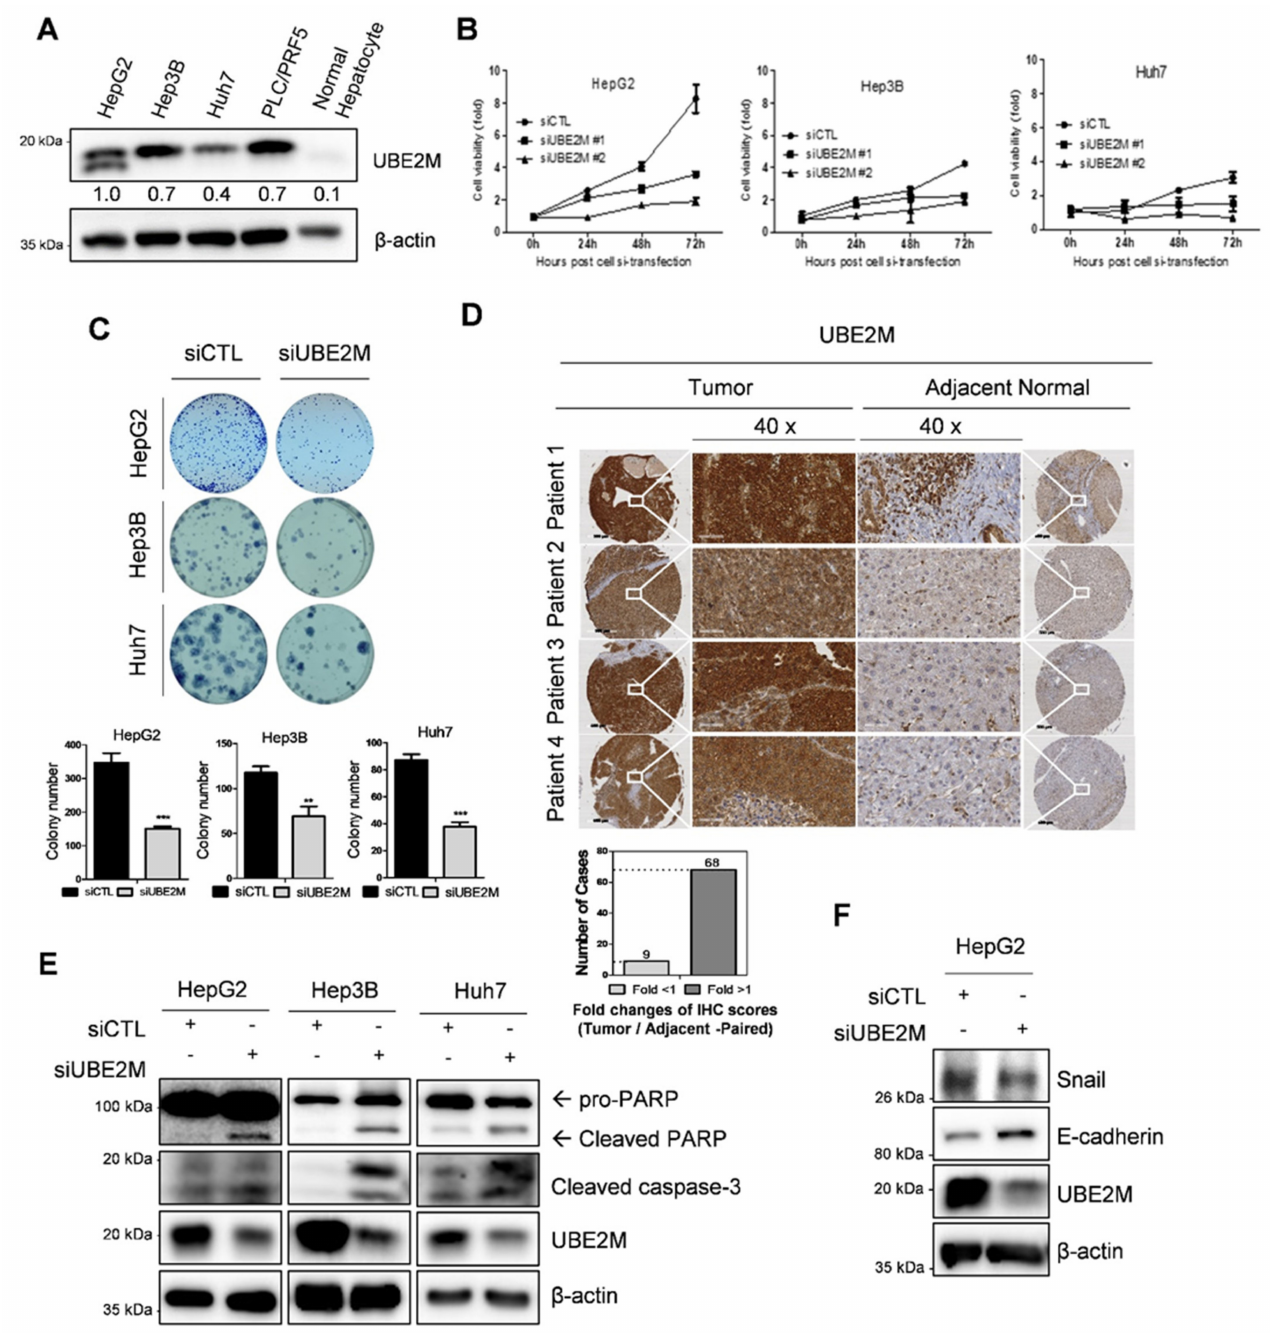
Figure 1. UBE2M overexpression in HCC cell lines and patient tissues, and cytotoxic and anti-proliferative effect of UBE2M depletion. ( A ) Endogenous expression level of UBE2M in hepatocellular carcinoma cell lines by Western blotting. ( B ) Effect of UBE2M depletion on the viability of HepG2, Hep3B and Huh7 cells. Cells were transfected with control and/or UBE2M siRNA-#1/siRNA-#2 and its cell viability was evaluated by MTT assay. Data represent means ± S.D from three independent experiments. ( C ) Effect of UBE2M depletion on the number of colonies in HepG2, Hep3B and Huh7 cells transfected with control and/or siRNA. Cells were cultured for 2 weeks in 12 well culture plate and stained. The number of colonies was counted. ( D ) UBE2M expression level in 80 patients’ liver cancer tissues and paired adjacent tissues using immunohistochemistry. 40 × magnification. Data represent means ± S.D from three independent experiments. ** p < 0.01, *** p < 0.001 vs. untreated control. ( E ) Effect of UBE2M depletion on PARP cleavage in HepG2, Hep3B and Huh7 cells transfected with control and/or UBE2M siRNA. Cells were lysed and immunoblotted with antibodies of PARP, cleaved caspase-3, UBE2M and β -actin. ( F ) Effect of UBE2M depletion on Snail, E-cadherin in HepG2